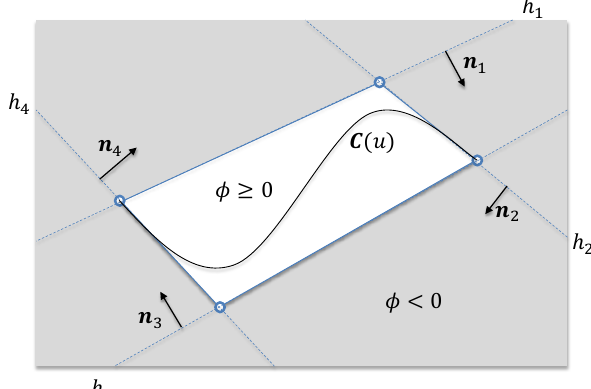
Figure 5. The control points of a cubic Bézier curve C ( u ) form a convex hull consisting of four hyper-planes h 1 , h 2 , h 3 and h 4 with inner normals n 1 , n 2 , n 3 , and n 4 , respectively. Boolean